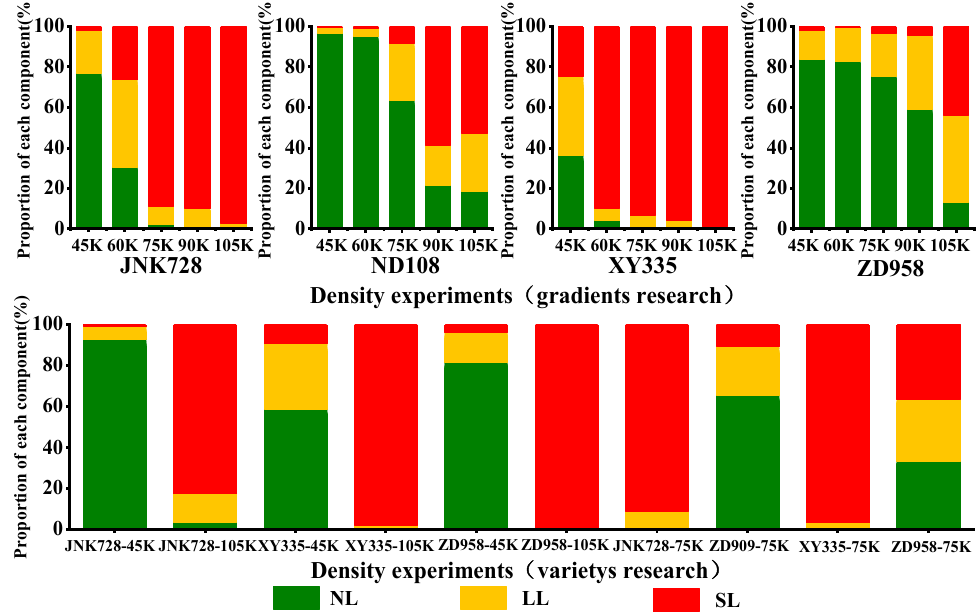
Figure 20. Fraction of NL, LL, and SL for various maize varieties at different planting densities. With increasing density, the fraction of NL decreases.